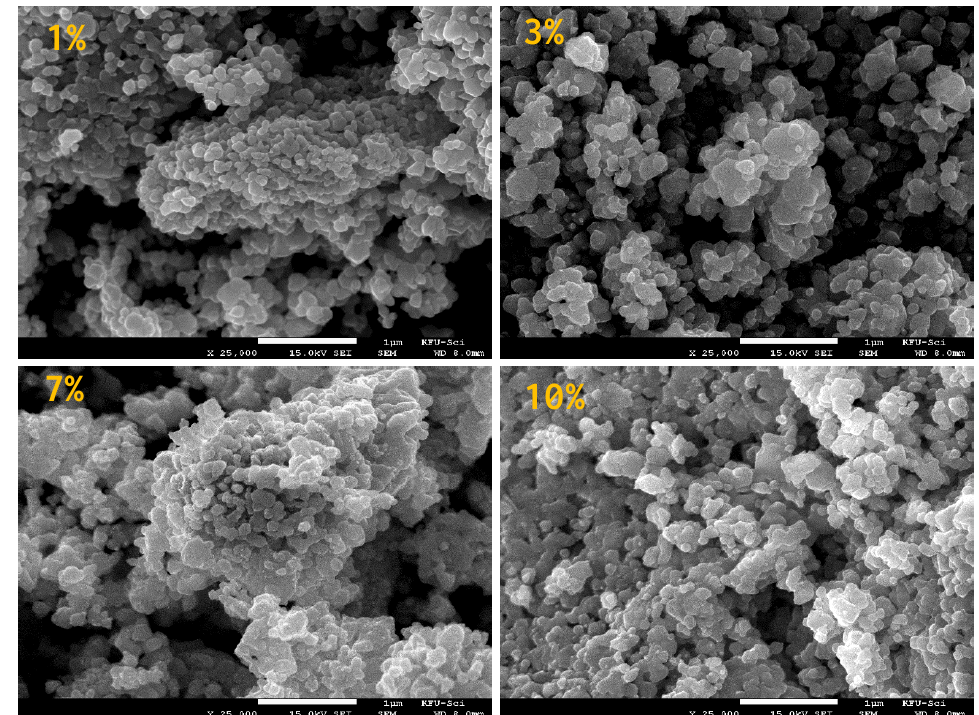
Figure 2. SEM images recorded at 25,000× magnification showing surface morphology of ZnNiO powders at 1%, 3%, 7% and 10% Ni doping percentages. The white colored bar-scale in the bottom of each image represents 1 μm.